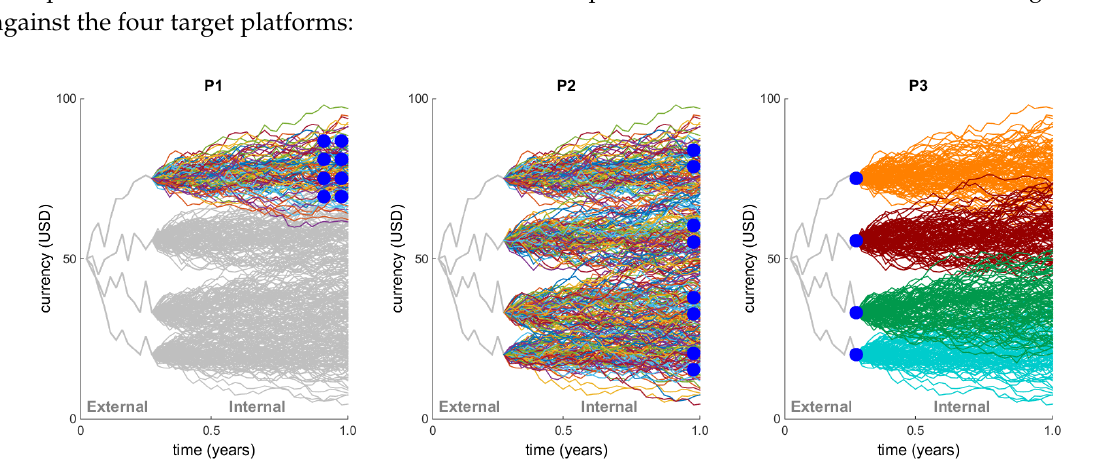
Figure 5. Parallelization schemes. The blue dots represent where the work items are assigned and how they are